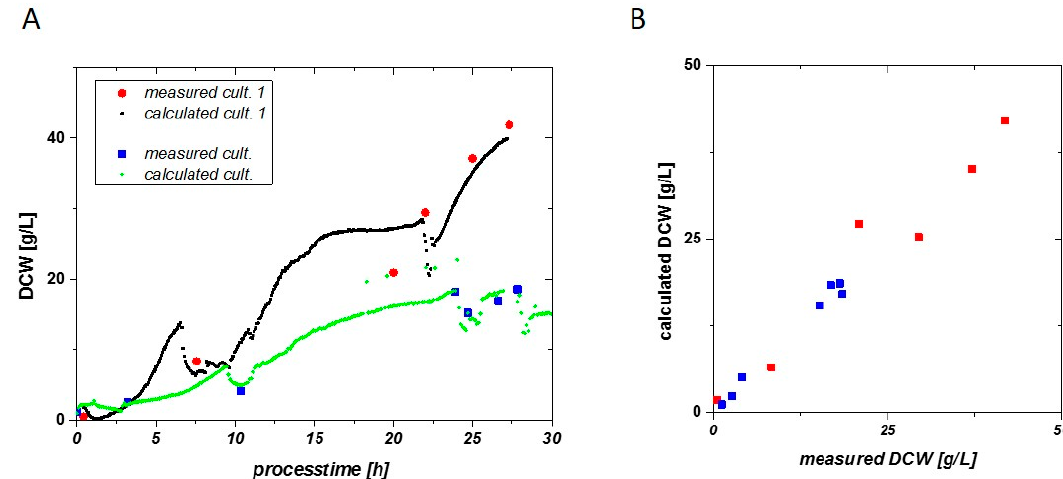
Figure 7. ( A ) DCW can be calculated by the online impedance signal very accurately. Determination of the VCC via double layer capacitance is reproducible for different E. coli cultivations; ( B ) Calculated DCW vs. measured DCW.